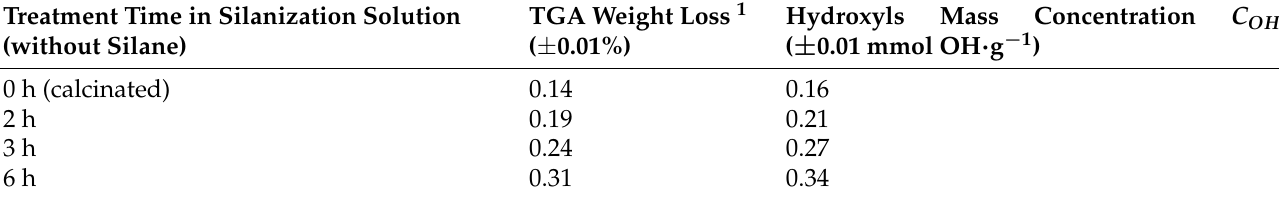
Table 1. TGA weight loss and hydroxyls surface concentration, for particles calcinated for 10 h, and then partially rehydroxylated in the silanization solution (without the silane) for 2 h, 3 h and 6